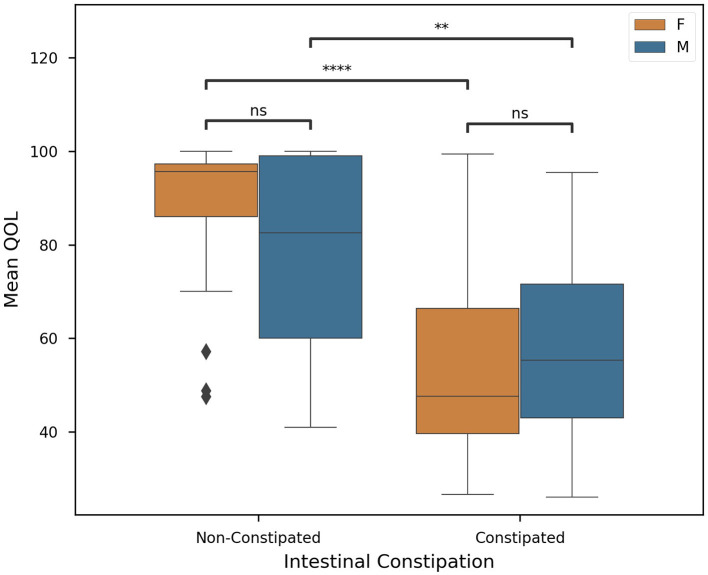
Quality of life in individuals with and without constipation according to sex. G1 presented lower values for all sections of the questionnaire when compared to G2, G3, and G4. In our cohort, we found constipated subjects to have significantly (p < 0.0001) lower QOL (56.09 ± 21.86) than those who were non-constipated (82.40 ± 19.35) (n = 93, significance was evaluated by two-tailed ANOVA, p-value < 0.05). Welch's t-tests were employed with Bonferroni corrections for (1) intersex intragroup comparisons and (2) intergroup intrasex comparisons (Key: ns - p ≥ 0.05, **p < 0.01, ****p < 0.0001).